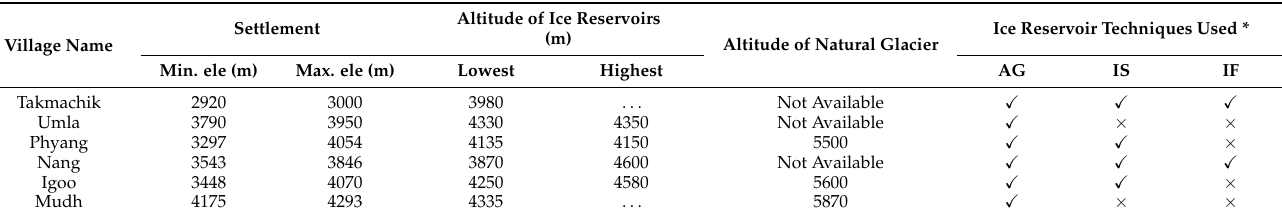
Table 3. Natural glaciers and Ice reservoirs in the study villages.